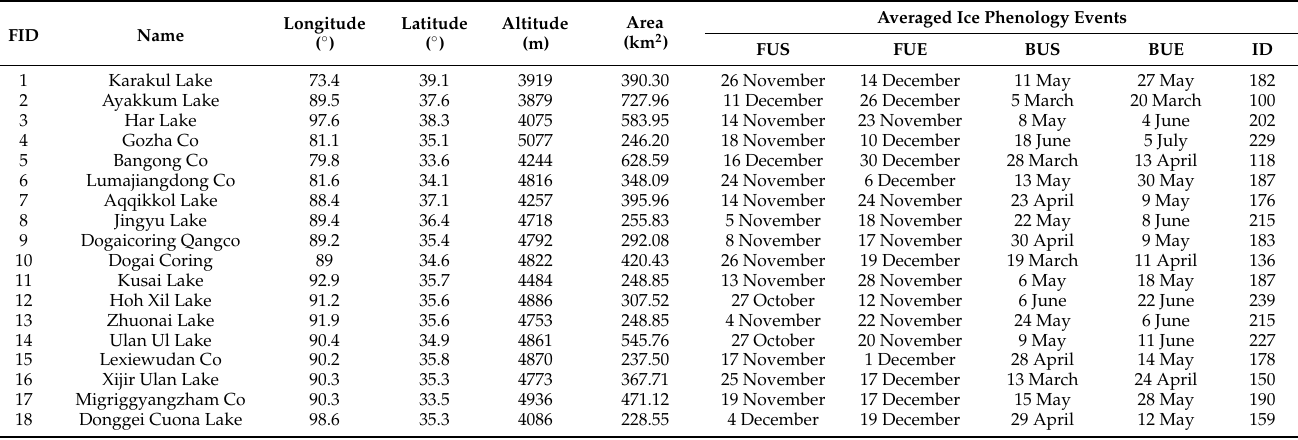
Lake attributes and average lake ice phenology parameters. The average